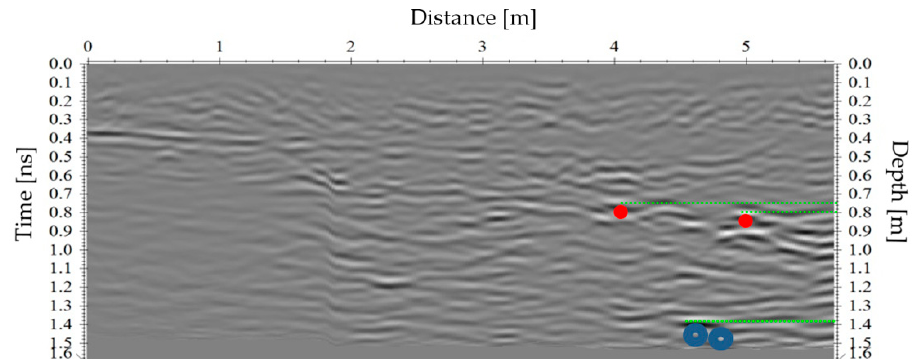
Figure 15. Time-to-depth conversion of profile 5 using a 900 MHz antenna with the velocity field calculated on the basis of the layer velocity method.